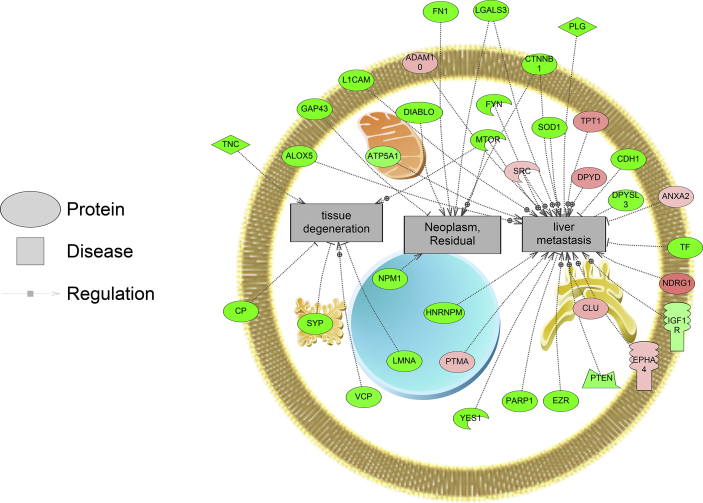
Protein network for tissue regeneration, neoplasms, and liver metastasis. Protein data were generated using iTRAQ proteomics. Red indicates that protein levels are increased for that protein and green indicates that the protein levels are decreased relative to control. The more intense the color, the larger the relative fold change of the protein compared to the control group. Circles indicate proteins, mushroom shaped entities with notches along the side represent receptors, while mushroom-shaped entities with notches on the bottom refer to transcription factors. Abbreviations are provided in Supplemental Data 4.